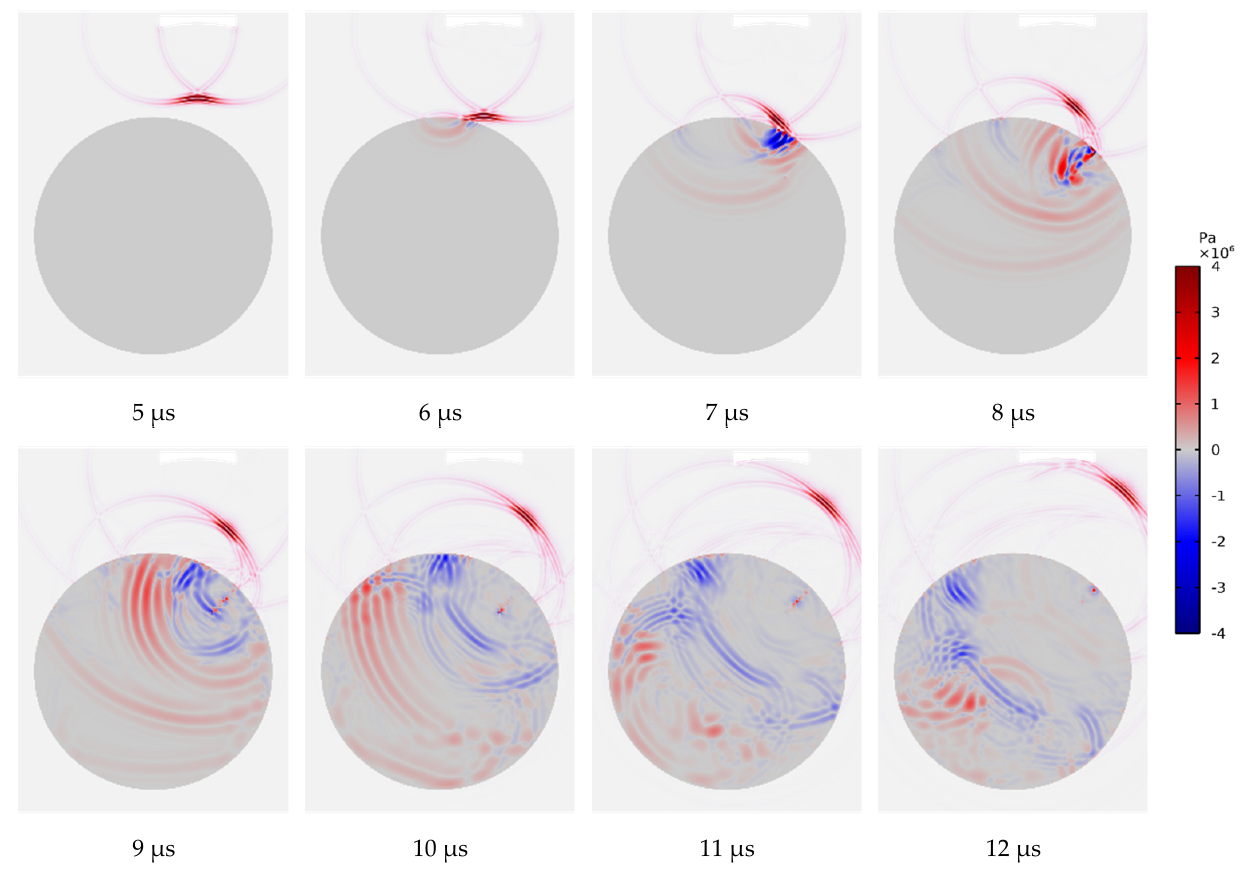
Figure 6. Snapshots of wave field for a smooth - surface notch.